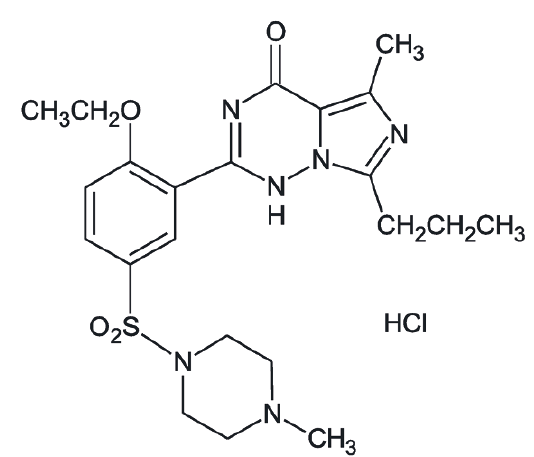
Figure 1. Chemical structure of